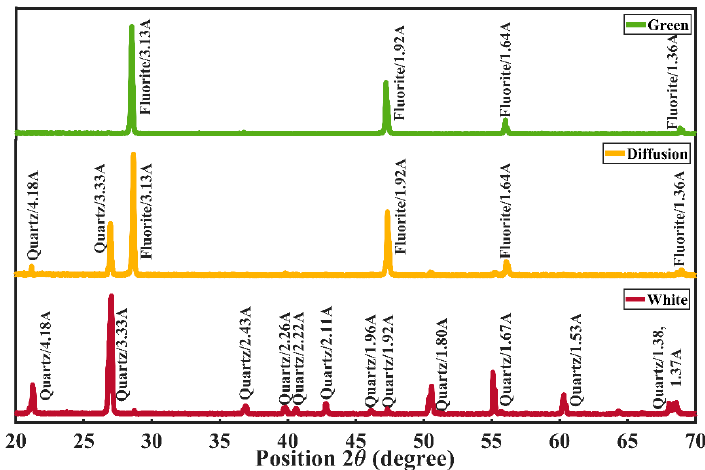
Figure 1. X-ray diffraction (XRD) pattern of white, pale green, and green zone of the sample showing the presence of mineral quartz (d spacing = 4.18, 3.33, and 1.67 Å) in the white zone, quartz-fluorite in the pale green zone and fluorite (d spacing = 3.13, 1.92, and 1.64 Å) in the green zone.